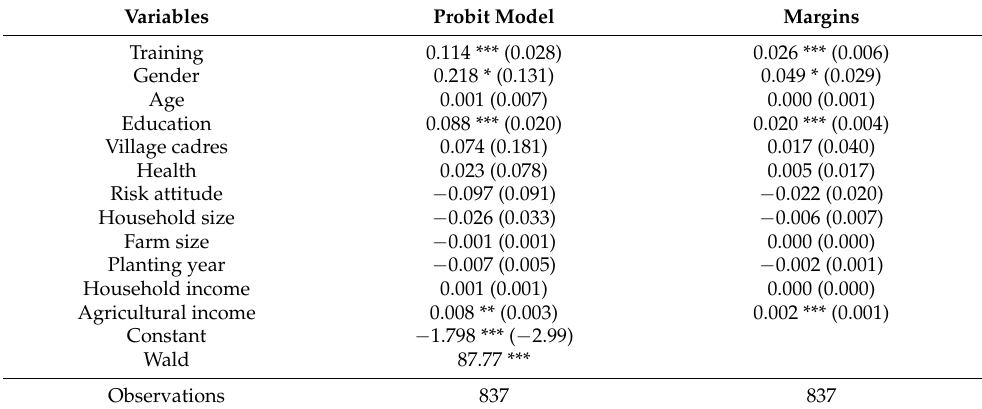
Table 2. Estimates of the Probit